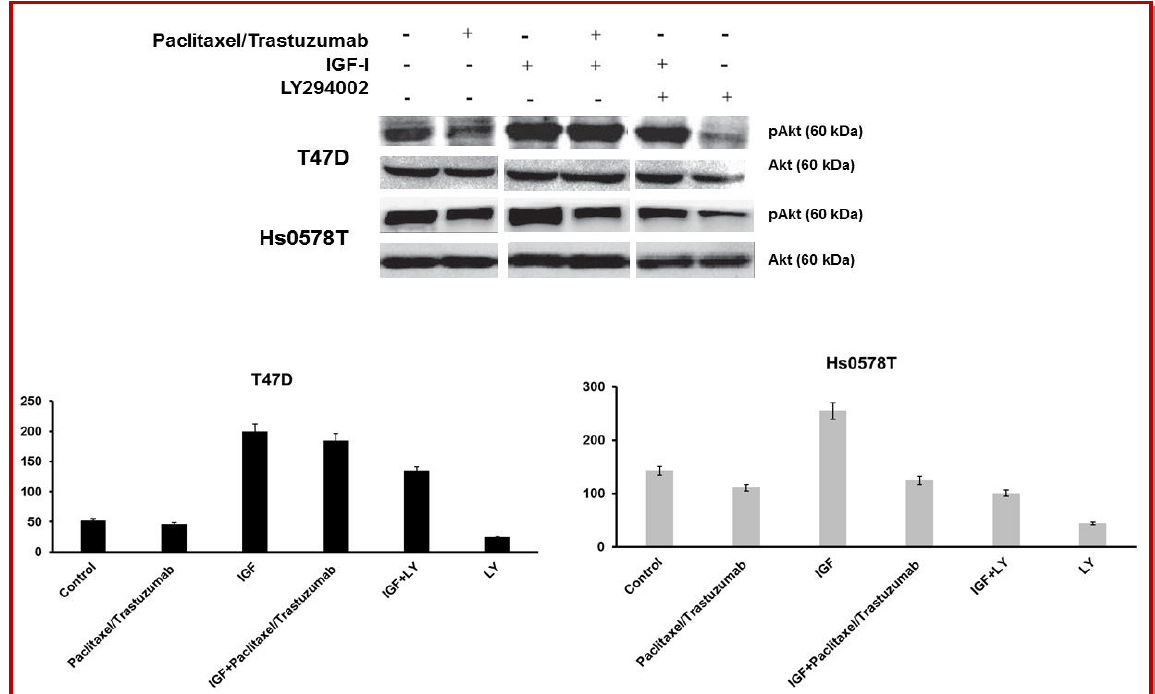
Figure 3: pAkt protein expression in T47D and Hs0578T cells treated with paclitaxel and trastuzumab and induced by IGF-1 and inhibited by LY294002